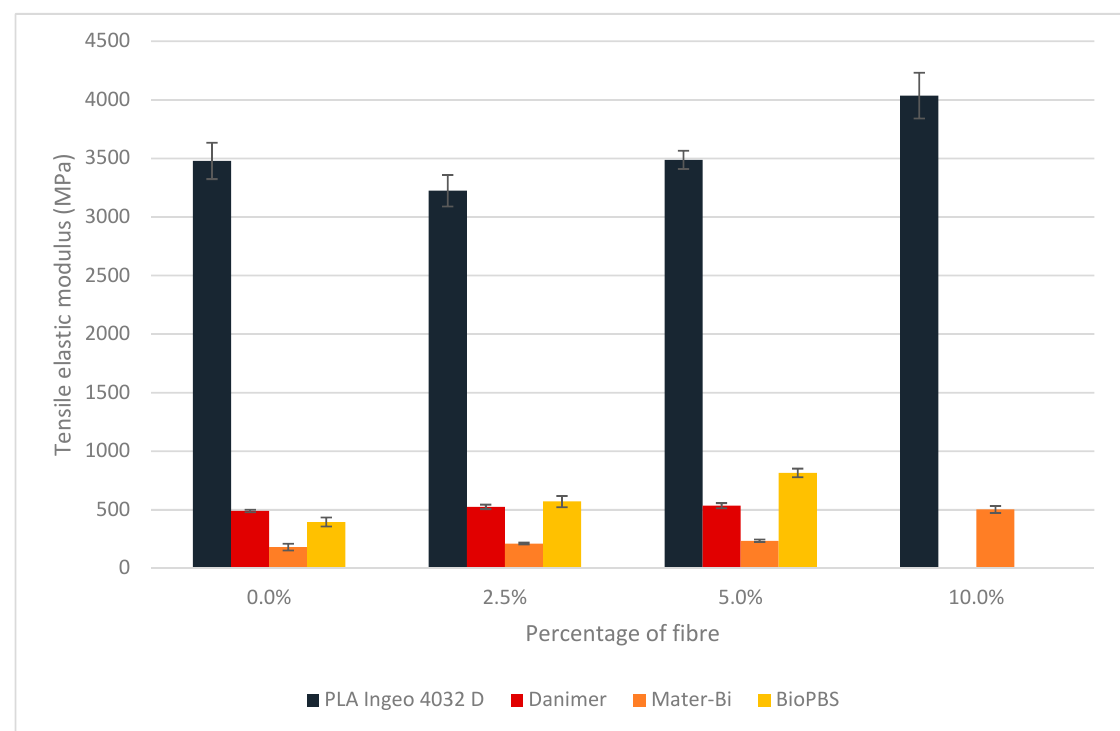
Figure 4. Comparison of tensile elastic modulus of the 1st generation compounds.